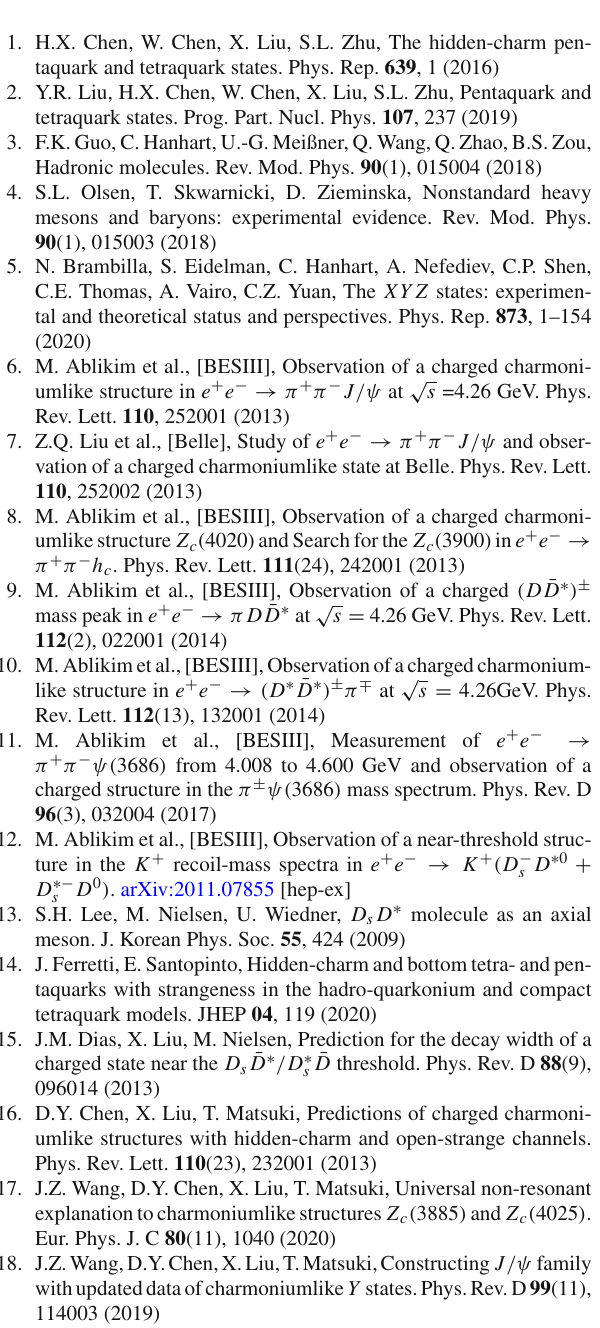
g Ds ∗ sY g KDDs 2 2 D g YD ∗ s